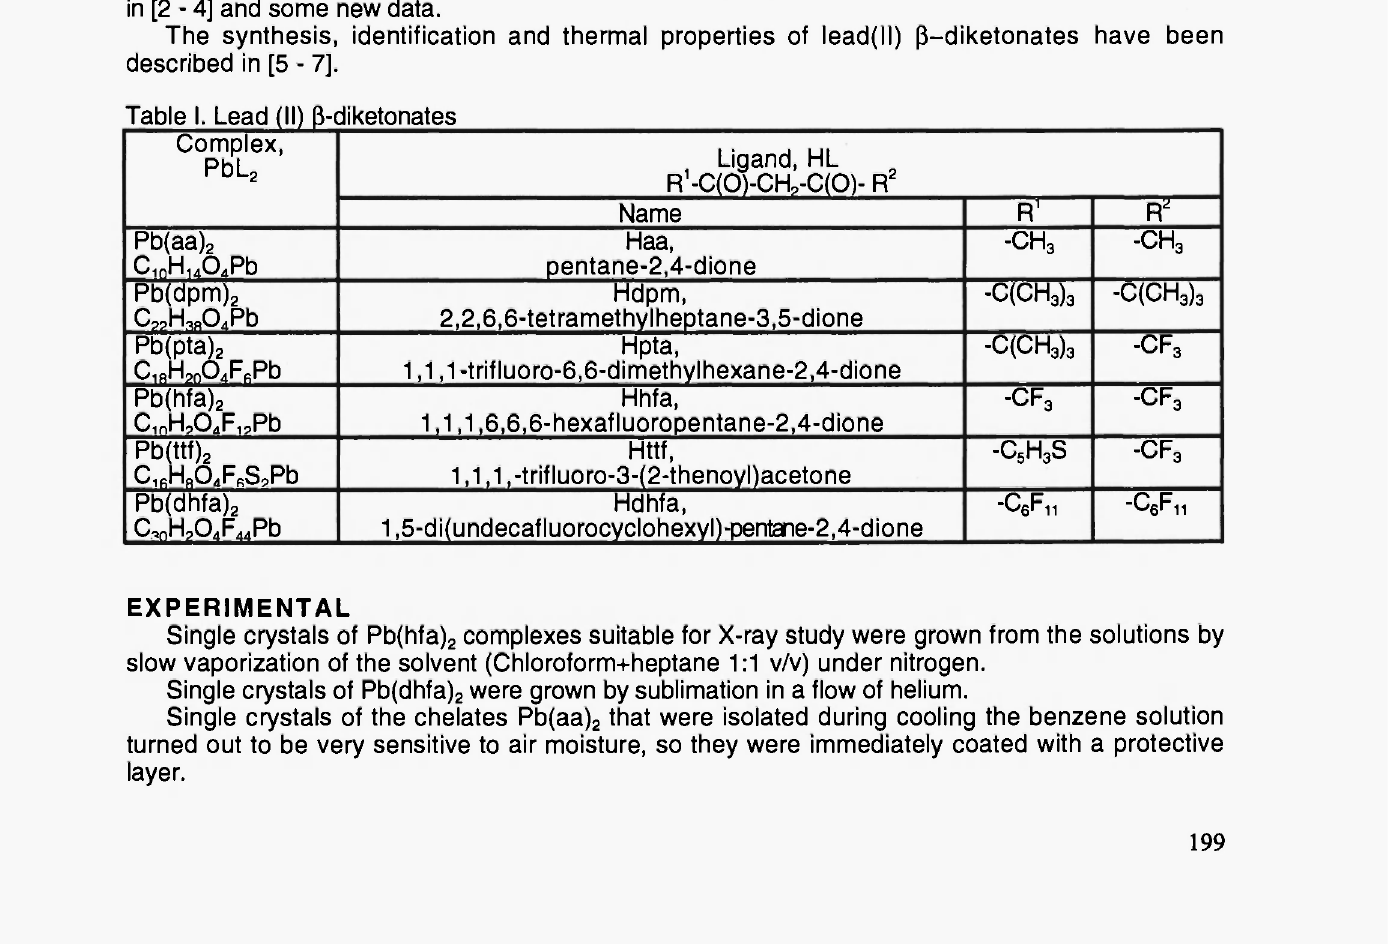
Table I. Lead (II) ß-diketonates